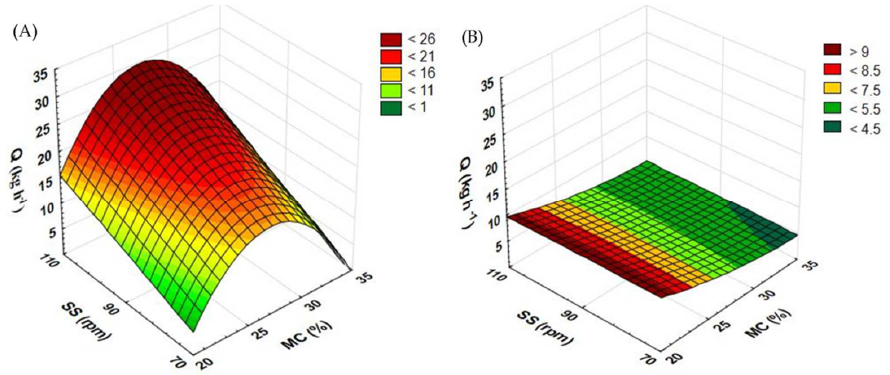
Figure 4. Efficiency of the extrusion-cooking of rapeseed straw ( A ) and buckwheat straw ( B ) before modification of the plasticizing system: MC—moisture content; SS—screw speed; Q—efficiency.